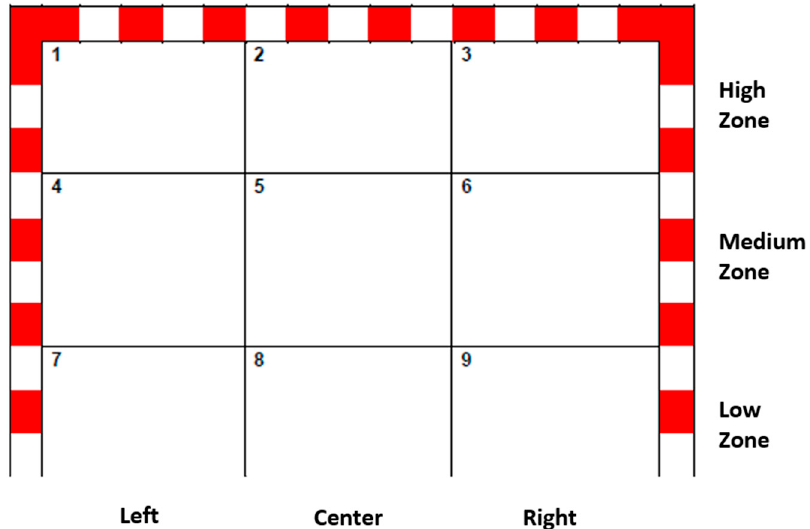
Figure 1. Score goal zones according to height and laterality.